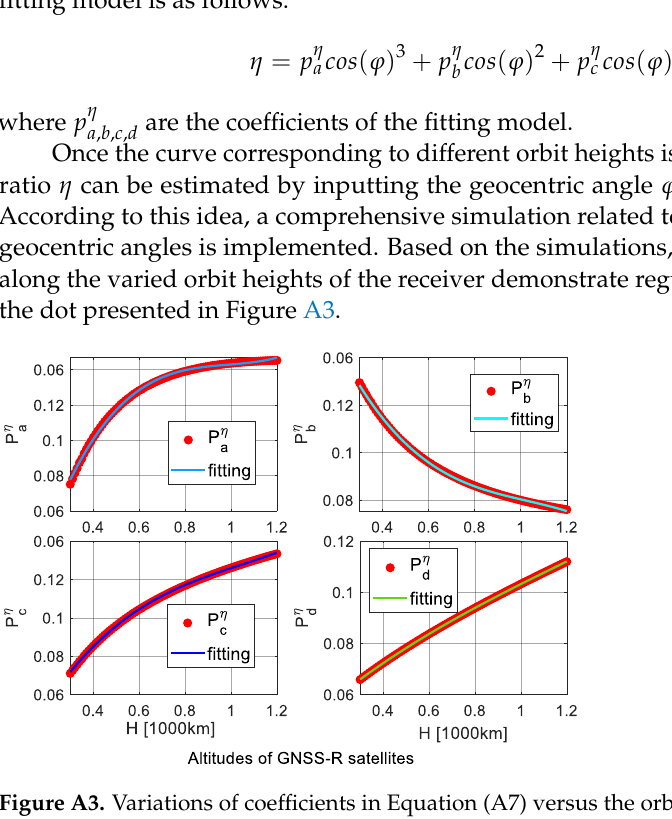
Figure A3. Variations of coefficients in Equation (A7) versus the orbital heights of the receiver. The results are obtained by the 100,000 simulations at each orbit height situation.